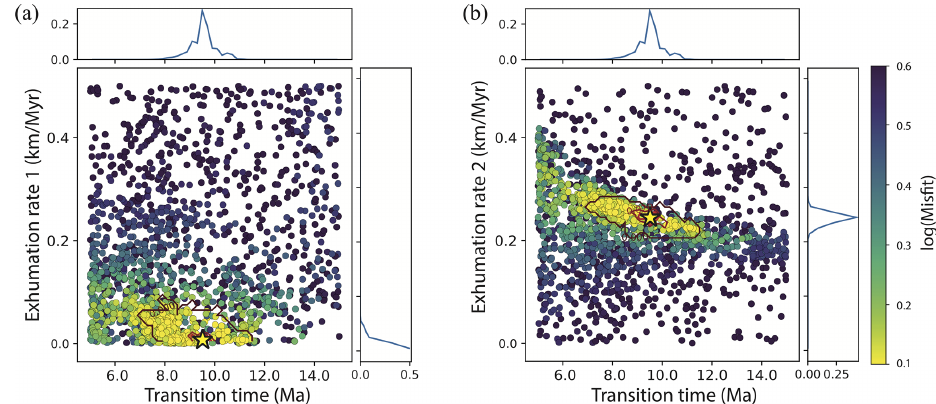
Figure 4. Scatterplots of Pecube inversion misfits for the plateau scenario model of the Baima Xueshan massif. Coloured dots represent individual forward-model runs plotted in two-dimensional projections of the parameter space, with colours corresponding to misfit values, shown on a log scale. Posterior probability density functions for parameter values are plotted along the axes. The best-fit solution is repre- sented by a yellow star with 2 σ (dark red) and 1 σ (light red) confidence contours. (a) Transition time (between first and second exhumation phase) versus exhumation rate during the first phase. (b) Transition time versus exhumation rate during the second